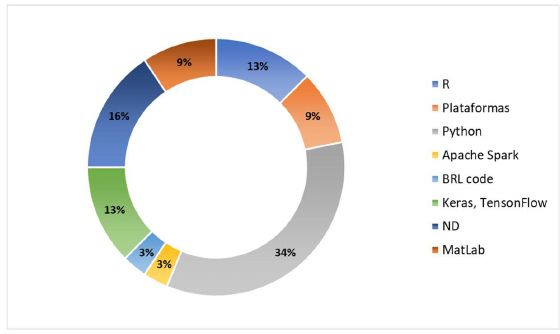
Figure 5. Tools distribution analysis.